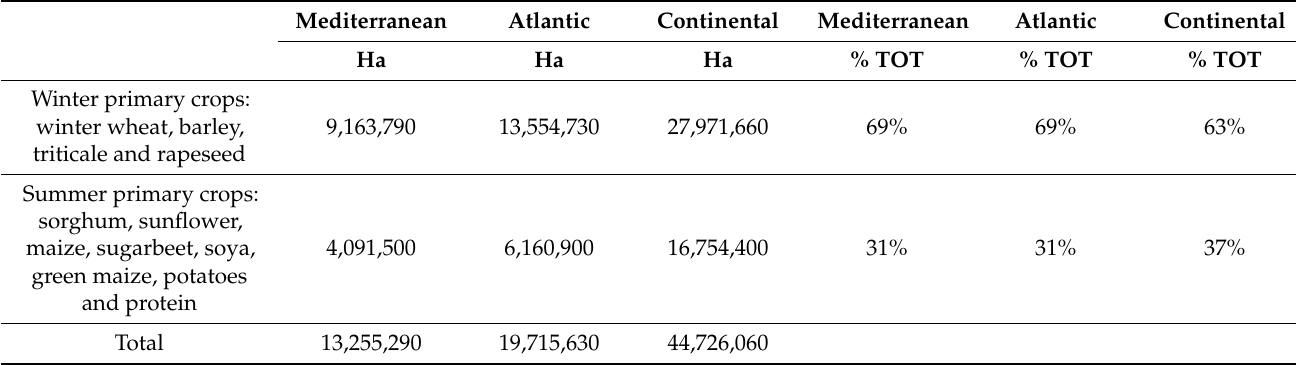
Table 5. Ratios of summer and winter crops on the total primary crop